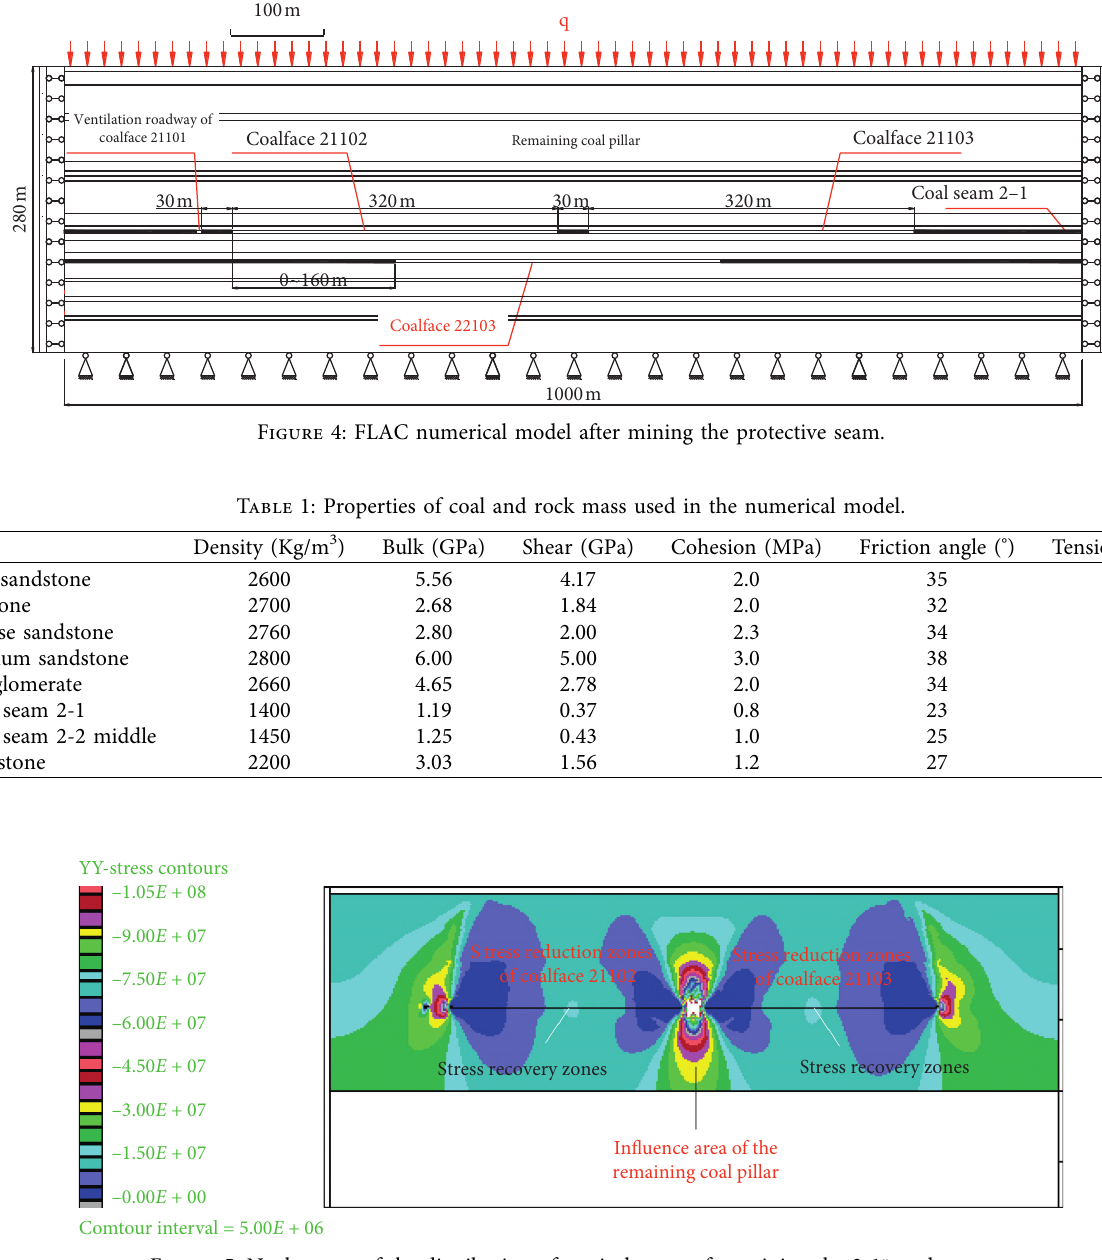
Figure 5: Nephogram of the distribution of vertical stress after mining the 2-1# coal